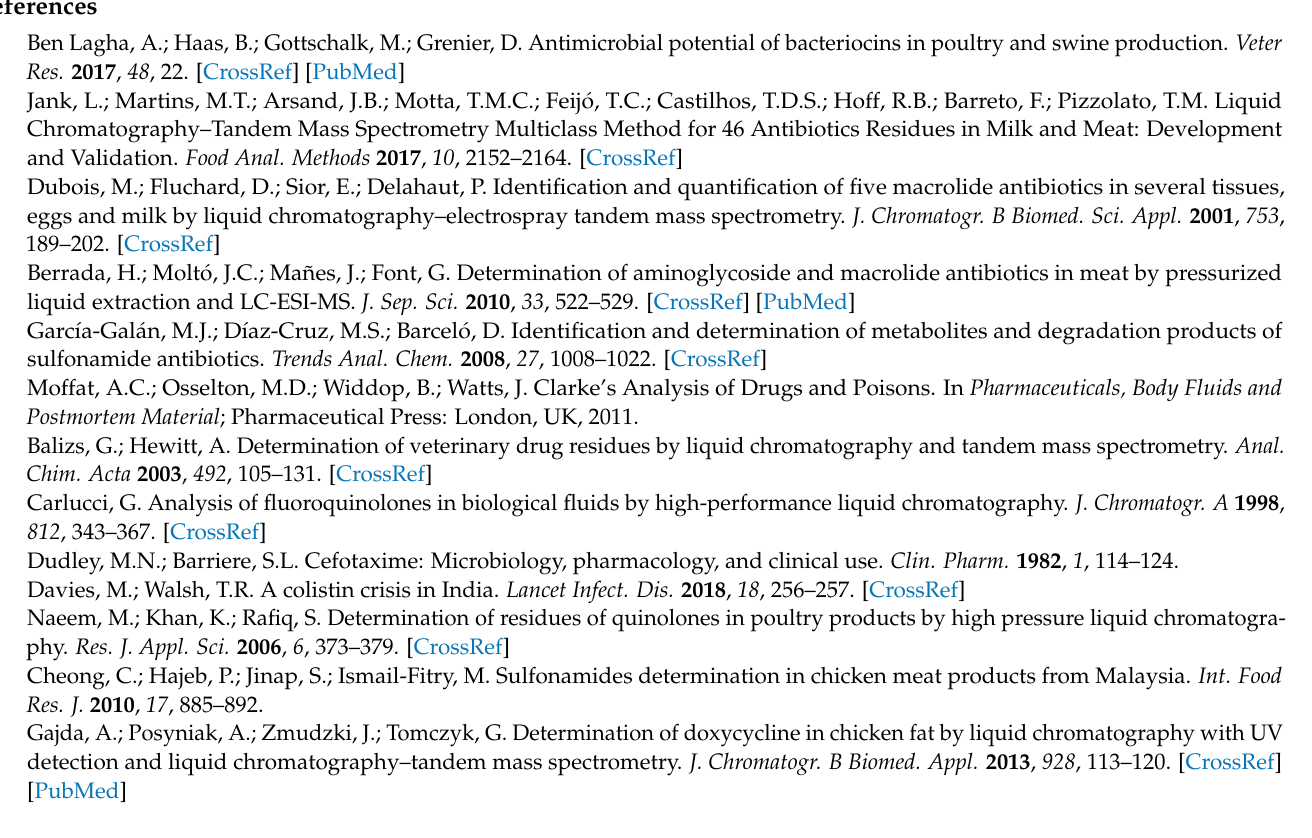
Table S13: Intra-day and inter-day precision of the LC-MS/MS method estimated by recovery of TMP, CIP, CTX, DOX, TYL, SMZ, FLU, and CST from the chicken sample; Table S14: Determination of the TMP, CIP, CTX, DOX, TYL, SMZ, FLU, and CST in laboratory prepared mixtures using the proposed (a) HPLC -UV (b) LC/MS/MS